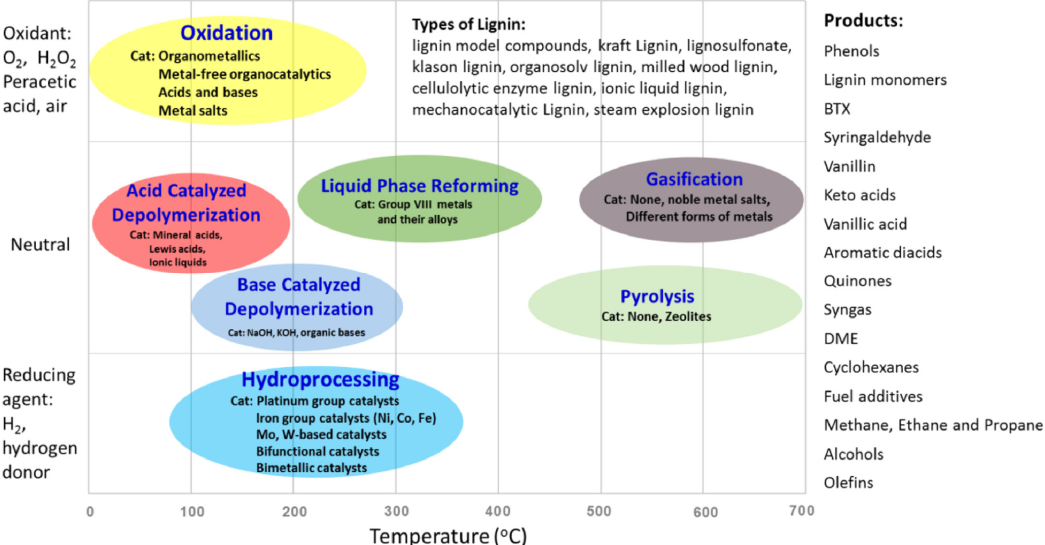
Figure 4. Processes for the conversion of lignin (the abscissa represents the typical temperature range of the lignin conversion processes) (reprinted with permission [36]. Copyright 2015 American Chemical Society).